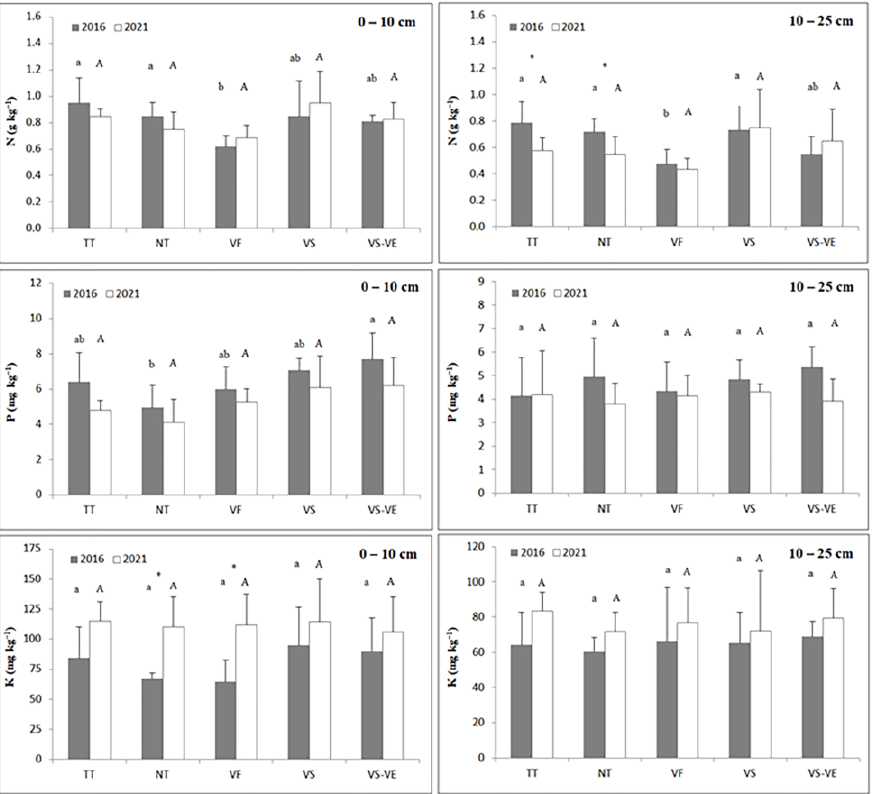
Figure 5. Average nitrogen (N), phosphorus (P), and potassium (K) contents by effect of different soil management strategies. TT, traditional tillage; NT, no tillage; VF, cover of V. faba ; VS, cover of V. sativa ; VS-VE, cover of V. sativa and V. ervilia . Bars are standard deviation. Different lowercase letters indicate significant differences at the beginning of the study; different capital letters indicate significant differences at the end of the study; *, indicates significant differences between the two sampling periods (Tukey’s test, p < 0.05).